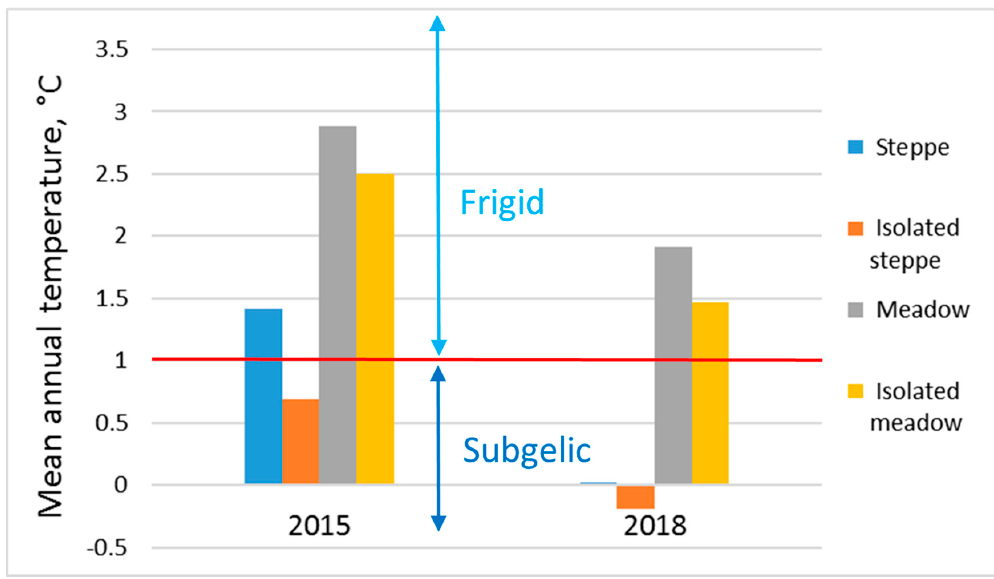
Figure 11. The change in the average annual temperature of alas soils at a depth of 0.2 m.